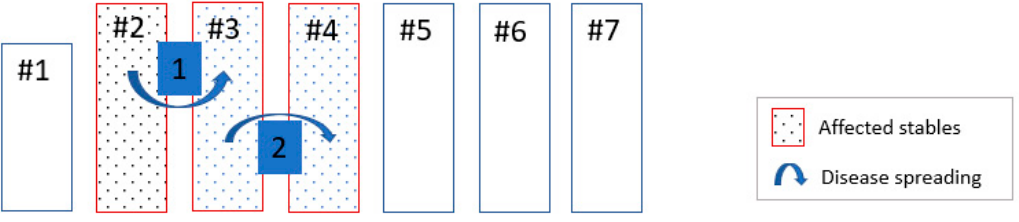
Figure 4. Potential spread of ASF virus between the stables in a Farm A.